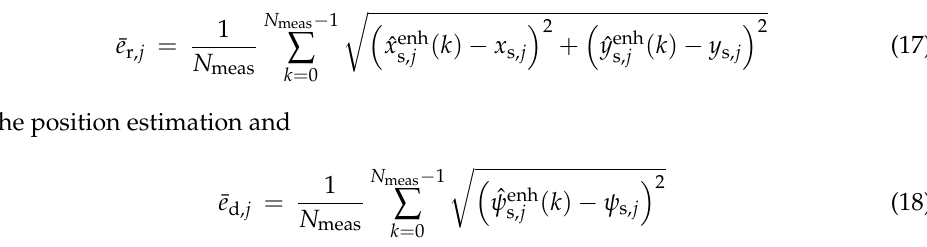
Figure 10. Real and estimated position and orientation of p of noise and cross talk in the measurement